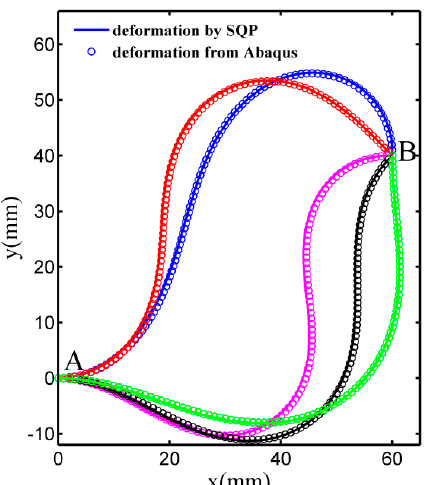
Figure 8. Comparison of the optimized deformed shape of the two point-contact guidewire computed via sequential quadratic programming (SQP) optimization or by ABAQUS.